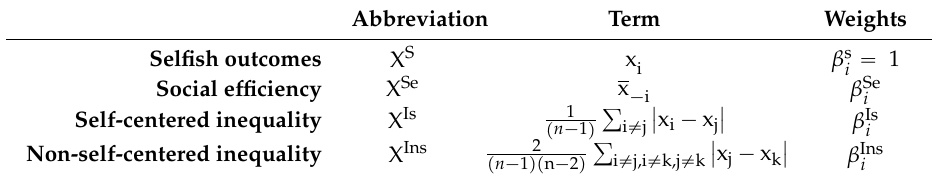
Table 1. Linear Terms for Selfish and Social Consequences in Multiplayer Dictator Games